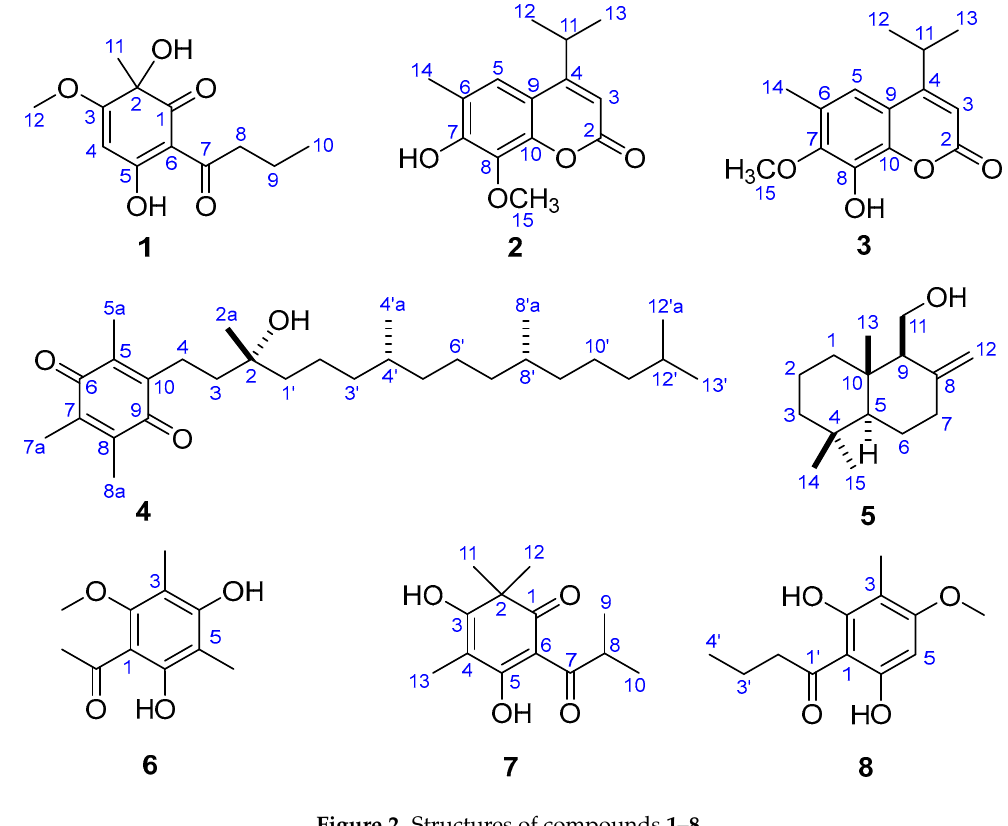
Figure 2. Structures of compounds 1 – 8 . Table 1. NMR data for Compound 1 (TMS as the internal standard, δ in ppm , J in Hz) a .